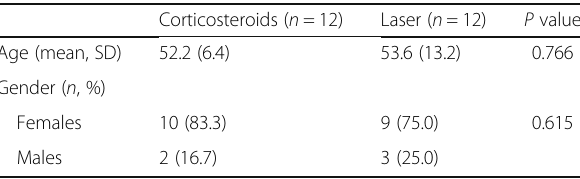
Table 1 Descriptive statistics and results of comparison between demographic data in the two